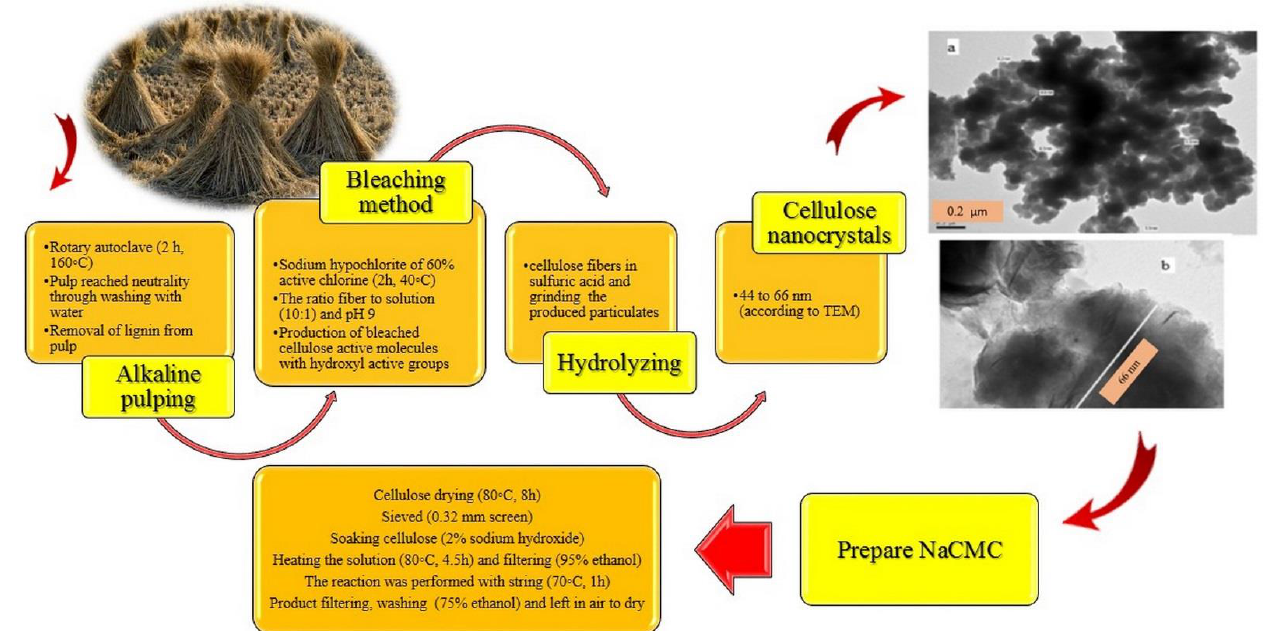
Figure 4. Cellulose production from rice straw and preparation of NaCMC.